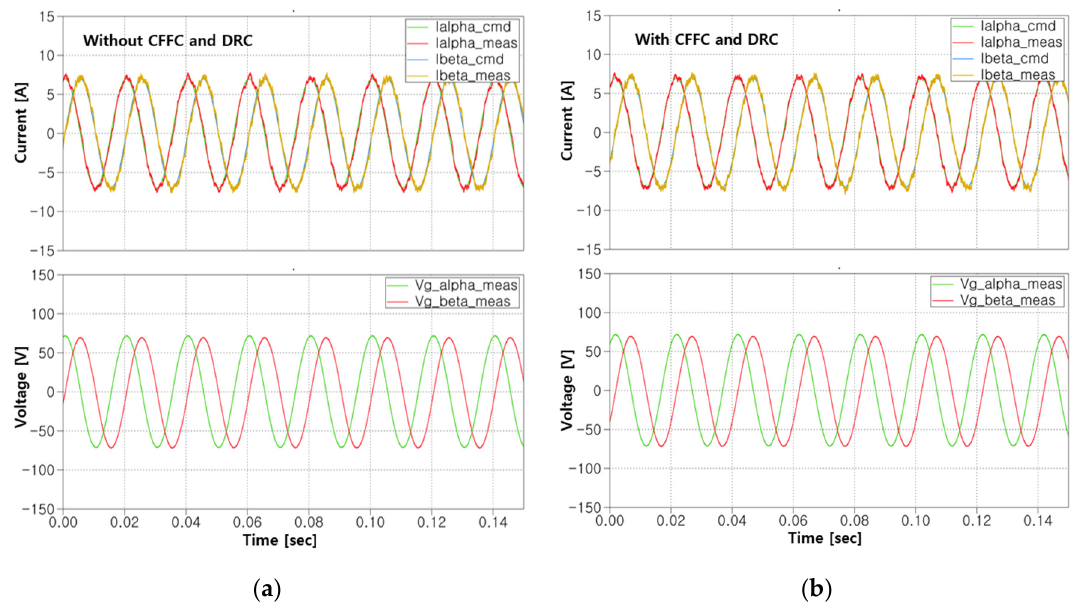
Figure 12. When normal grid condition, experimental results of proposed method a stationary reference frame grid currents and grid voltages ( a ) without CFFC and DRC and ( b ) with CFFC and DRC.